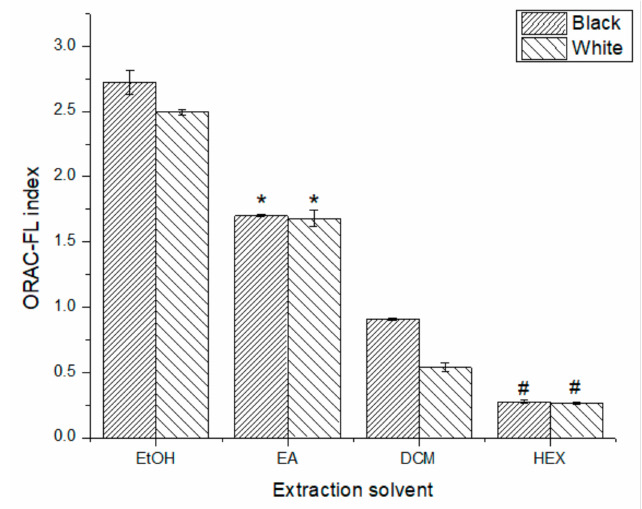
Figure 1. ORAC-FL index for all extracts tested. *, # No significant difference ( p > 0.05). In order to compare with available literature data, ASE global extractions were per- formed following the protocol reported by Wu et al. [18], using AWA as an extractant. An average ORAC-FL AC of 24,061 ± 2609 µ mol TE/100 g of dw was found for B-SPLE and 9973 ± 3128 µ mol TE/100 g of dw for W-SPLE. For the ORAC-PGR AC assay (Figure 2), the concentration of HEX and DCM extracts was doubled (10,000 mg L − 1 ) for both phenotypes; even so, these extracts did not mark antioxidant reactivity. Again, the best extract was B-EtOH (0.079 ± 0.001 followed by W-EA (0.074 ± 0.003). For global extraction (AWA), a mean of 371 ± 99 µ mol TE/100 g of dw for B-SPLE and 381 ± 22 µ mol TE/100 g of dw for W-SPLE were calculated.